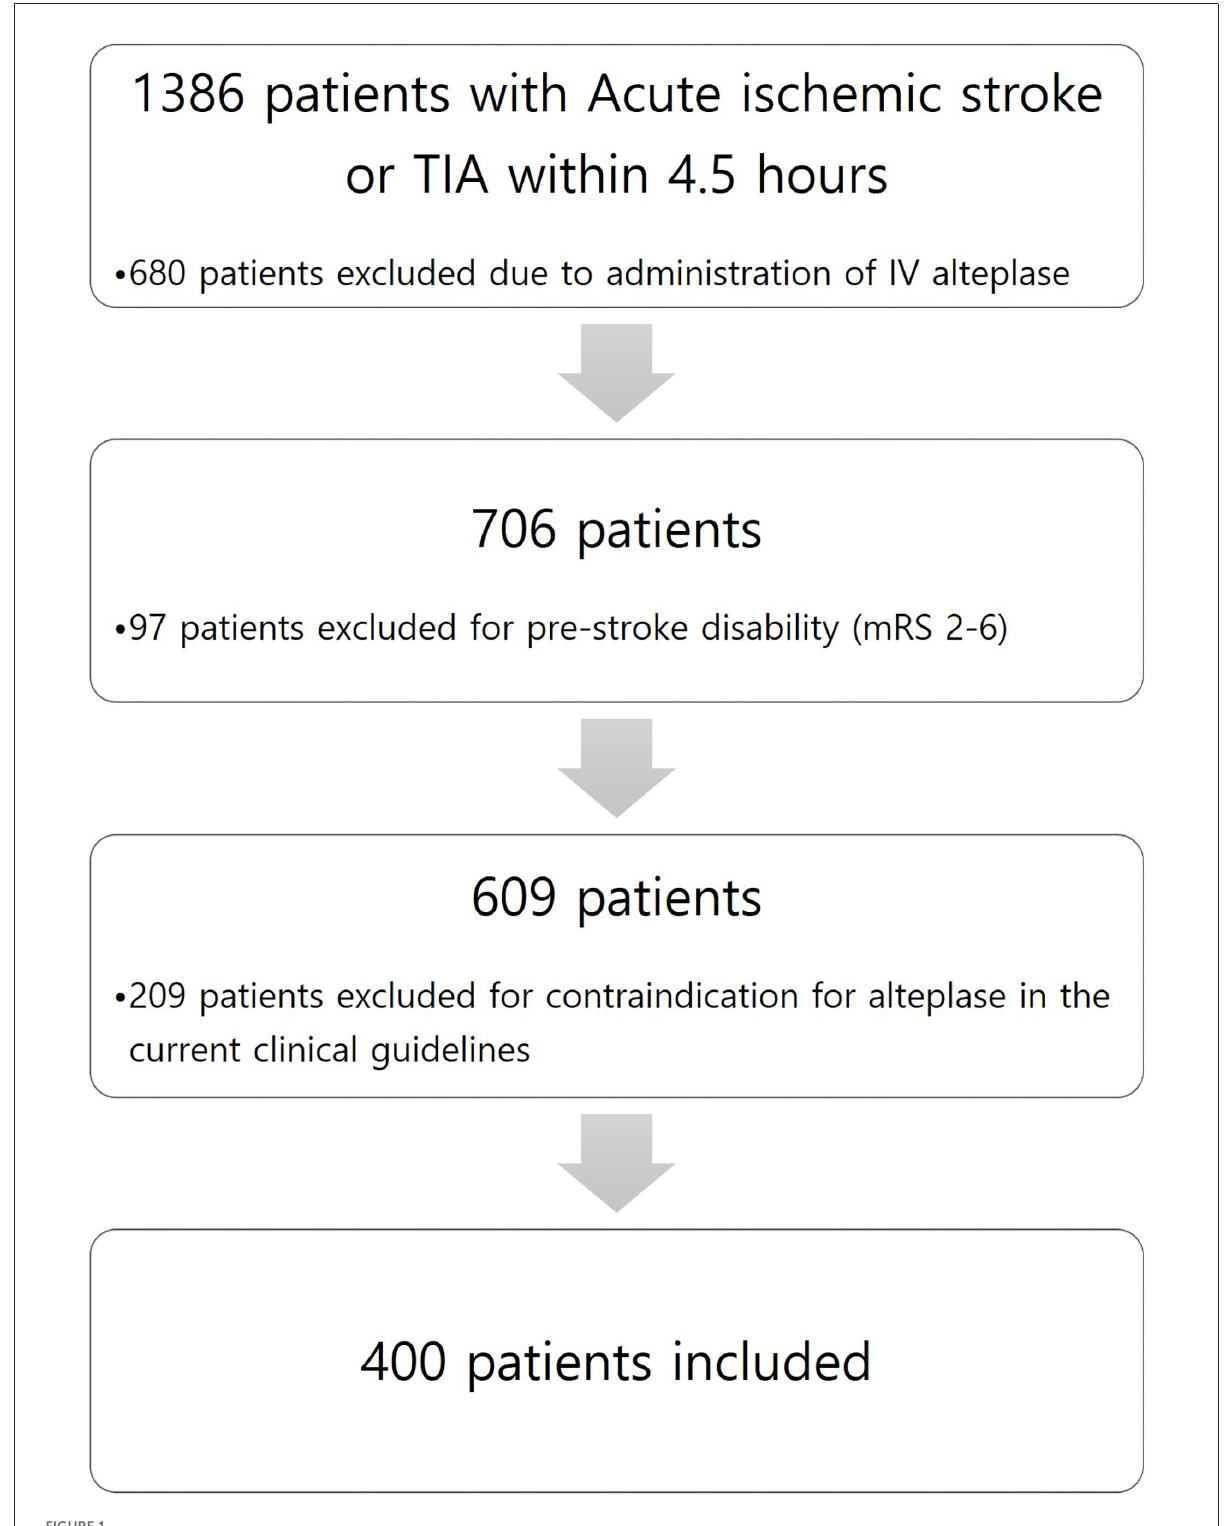
FIGURE1 Patient flow of this